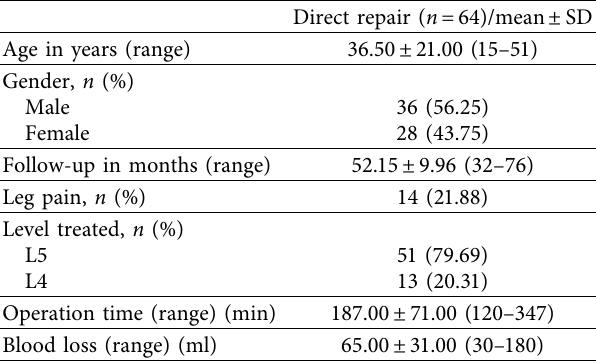
Table 1: General data (mean ± SD/M ±